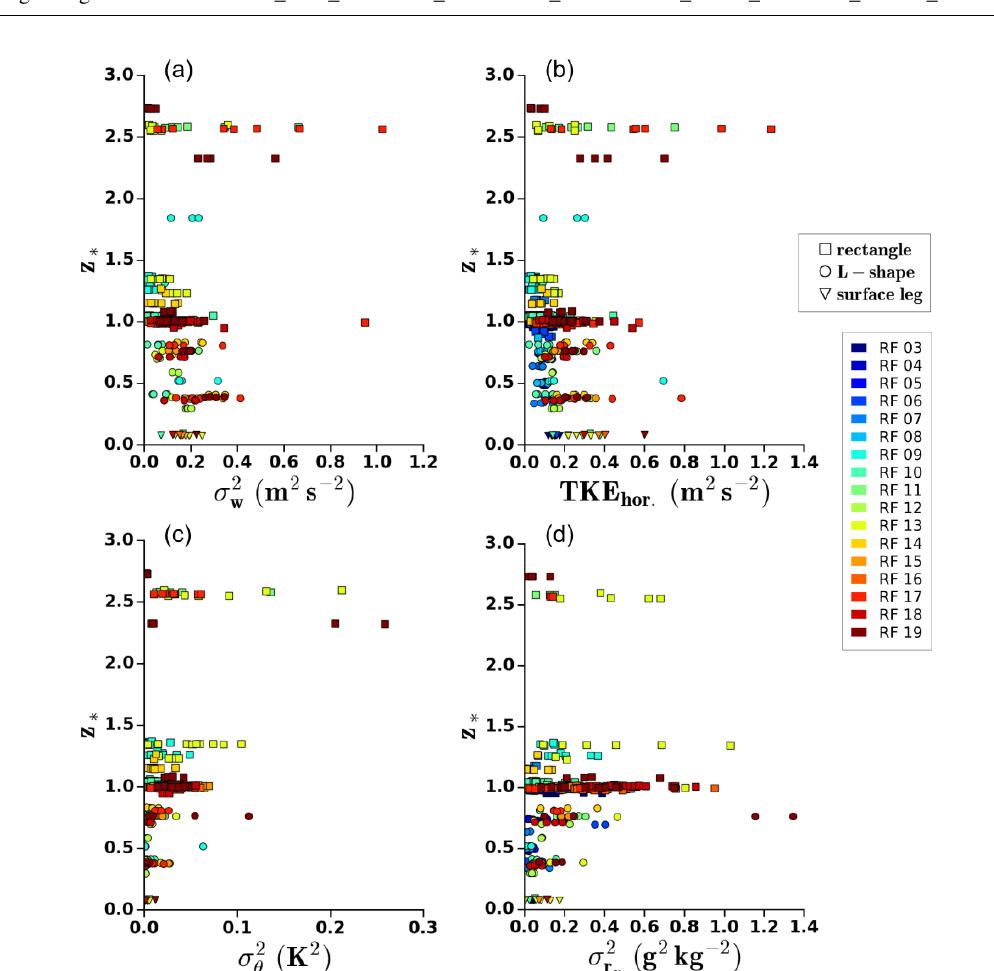
Figure 15. Normalized vertical profiles of the variance of (a) vertical velocity, (b) horizontal turbulent kinetic energy, (c) temperature and (d) water vapor mixing ratio. Flight numbers are indicated in the top right box. For the water vapor mixing ratio, only the legs with a green or a yellow combined flag have been considered. The normalized altitude z ∗ is defined by z/ LCL with LCL, the lifting condensation